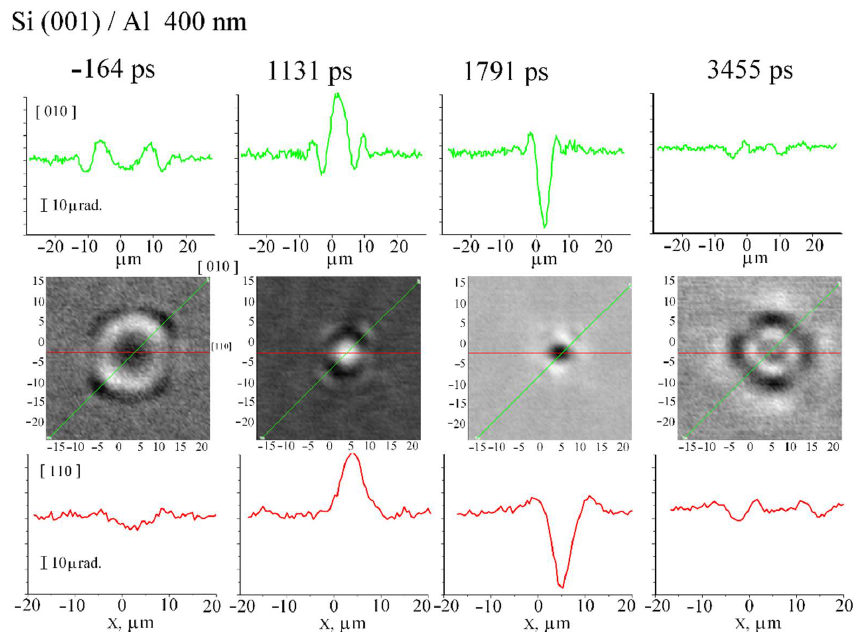
Figure 5. Center block of pictures: converging SAW field on silicon with orientation (001) covered by aluminium film at several time moments. Green lines indicate lateral direction [010], red lines indicate lateral direction [110]. Top block and bottom block of pictures show SAW profile along these lines, respectively.